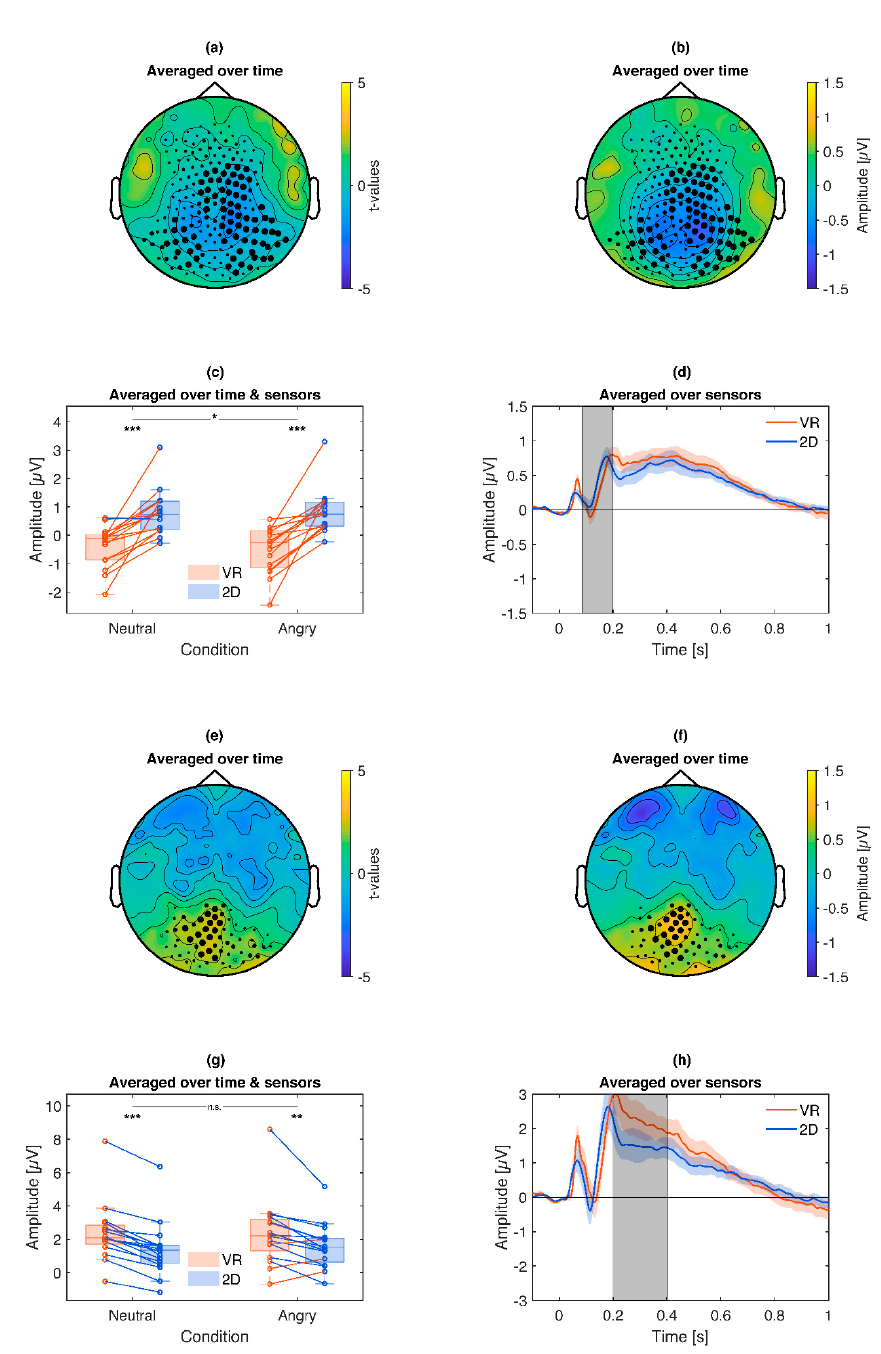
( b ) Figure 10. Illustration of the VR vs. 2D ERP e ff ect: ( a – d ) VR stimulation leads to overall stronger ERPs and specifically more so for angry faces in an earlier time frame. ( e–h ) VR stimulation also leads to overall stronger ERPs in the time frame of the LPP and P3. ( a ) & ( e ): Topography of t -values averaged across the significant time points. ( b ) & ( f ): Topography of the scalp potential di ff erence. ( c ) & ( g ): Box plot and single subject values from the respective cluster. Blue lines indicate a more positive ERP for VR compared to 2D conditions, red the opposite. Asterisks illustrate the significance of exploratory post-hoc subgroup comparisons: *** p < 0.001, ** p < 0.01, * p < 0.05, ns p > 0.05. ( d ) & ( h ): Time course of the respective cluster. Colored shaded areas signify standard errors. Grey shaded areas signify the latency of the